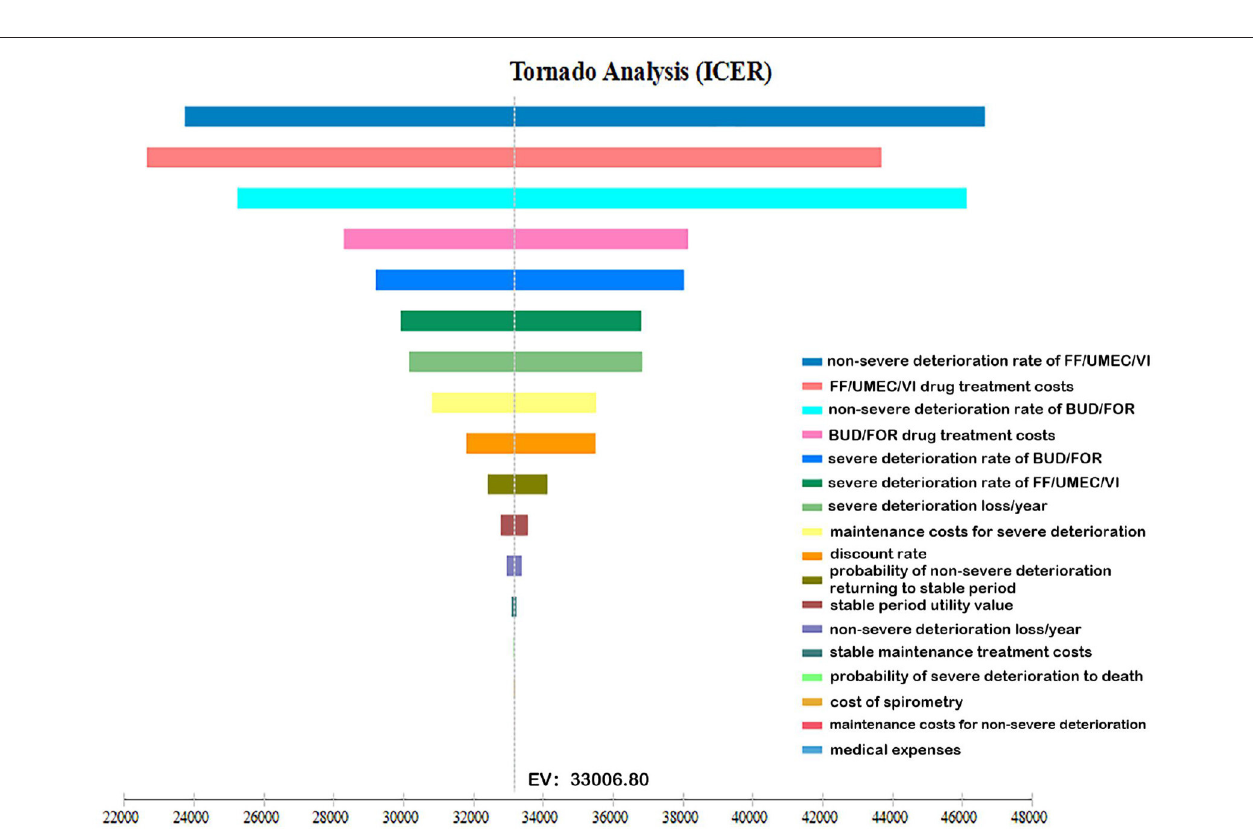
FIGURE 2 | One-way sensitivity analysis tornado diagram. The influencing factors from highest to lowest are: A: non-severe deterioration rate of FF/UMEC/VI; B: FF/UMEC/VI drug treatment costs; C: non-severe deterioration rate of BUD/FOR; D: BUD/FOR drug treatment costs; E: severe deterioration rate of BUD/FOR; F: severe deterioration rate of FF/UMEC/VI; G: severe deterioration loss/year; H: maintenance treatment costs for severe deterioration period; J: discount rate; K: probability of non-severe deterioration returning to stable period; L: stable period utility value; M: non-severe deterioration loss/year; N: stable maintenance treatment costs; O: probability of severe deterioration returning to death; P: cost of spirometry; Q: maintenance treatment costs for non-severe deterioration; R: medical